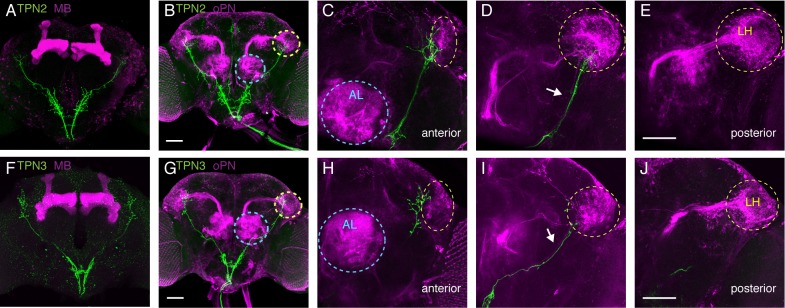
TPNs arborize near olfactory projection neurons.(A) Co-labeling of TPN2 (green) and mushroom bodies (magenta) shows no overlap. (B) Co-labeling of TPN2 (green) and olfactory projection neurons (magenta) shows overlap in lateral horn (LH). Blue circles indicate antennal lobes (AL), yellow circles indicate LH. (C–E) Anterior to posterior sections of (B). White arrow points to lALT, running parallel to the TPN2 axon. (F) Co-labeling of TPN3 (green) and mushroom bodies (magenta) shows no overlap. (G) Co-labeling of TPN3 (green) and olfactory projection neurons (magenta) shows overlap in LH. (H–J) Anterior to posterior sections of (G). Scale bar, 50 μm.